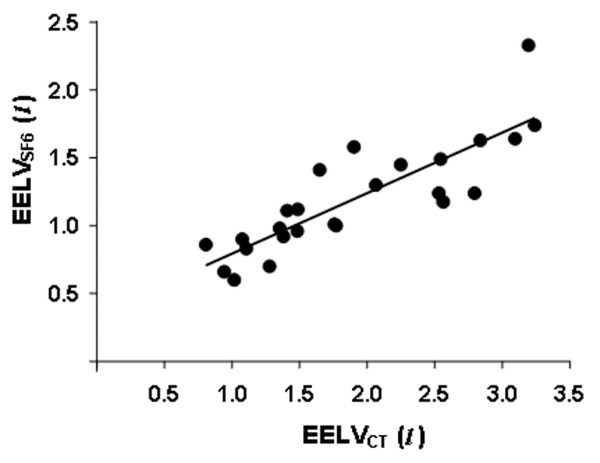
Linear regression between EELV measurements by rebreathing of sulphur hexafluoride (EELVSF6) and by computed tomography (EELVCT) obtained in 25 ARDS patients. The dotted line is the regression line EELVSF6 = 0.4EELVCT + 0.3 (r2 = 0.72; P < 0.001).